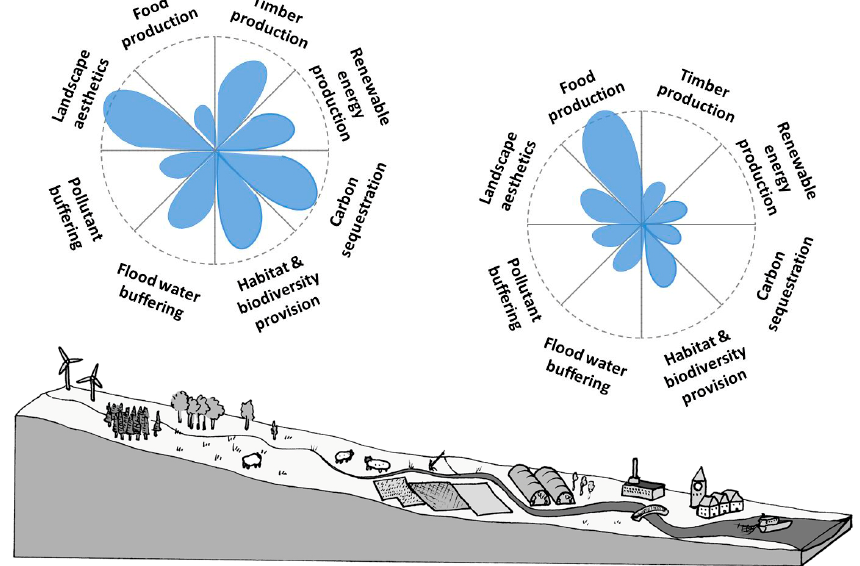
Figure 2. ‘Flower diagrams’ illustrating perceived multiple ecosystem service provision in an upper and lower catchment. Ecosystem service provision was indicated by stakeholders (academics ( n = 9), environmental regulator staff ( n = 5), NGO staff ( n = 3) and farmer’s union staff ( n = 2)) to estimate how they perceive provisioning in a generic Scottish upland and lowland catchment. Mean (±SE) perceived ecosystem service provisioning (as a percentage of the total provisioning of the services in both parts of the catchment (total = 200%) for the upper (U) and lower (L) catchment were: Food production: U = 6.8 ± 0.9, L = 28.1 ± 3.0; Renewable energy production: U = 12.6 ± 1.7, L = 6.3 ± 1.3; Timber production: U = 19.5 ± 1.9, L = 7.0 ± 1.4; Carbon sequestration: U = 24.8 ± 3.0, L = 5.7 ± 0.8; Habitat & biodiversity provision: U = 22.8 ± 1.9, L = 10.1 ± 1.9; Flood water buffering: U = 17.8 ± 1.9, L = 8.0 ± 1.3; Pollutant buffering: U = 8.7 ± 1.8, L = 7.2 ± 1.2; Landscape aesthetics: U = 28.8 ± 2.0, L = 10.8 ± 1.6.